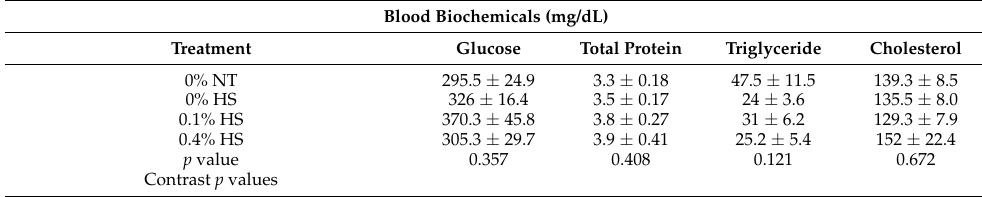
Table 4. Effects of supplementing diets with solubles from shredded, steam-exploded pine particles (SSPPs) on the blood metabolites in broiler chickens exposed to either thermoneutral or heat-stress